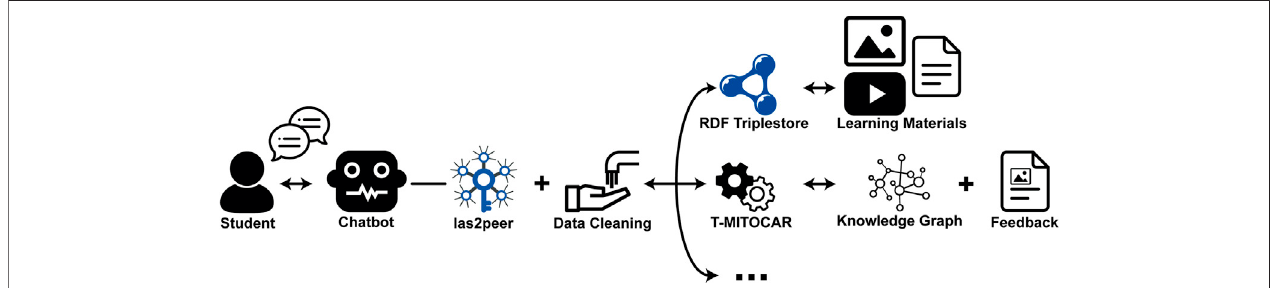
FIGURE 1 | Deployed architecture: The student communicates with the las2peer based chatbot which can access different services like T-MITOCAR or (RDF) databases to provide mentoring